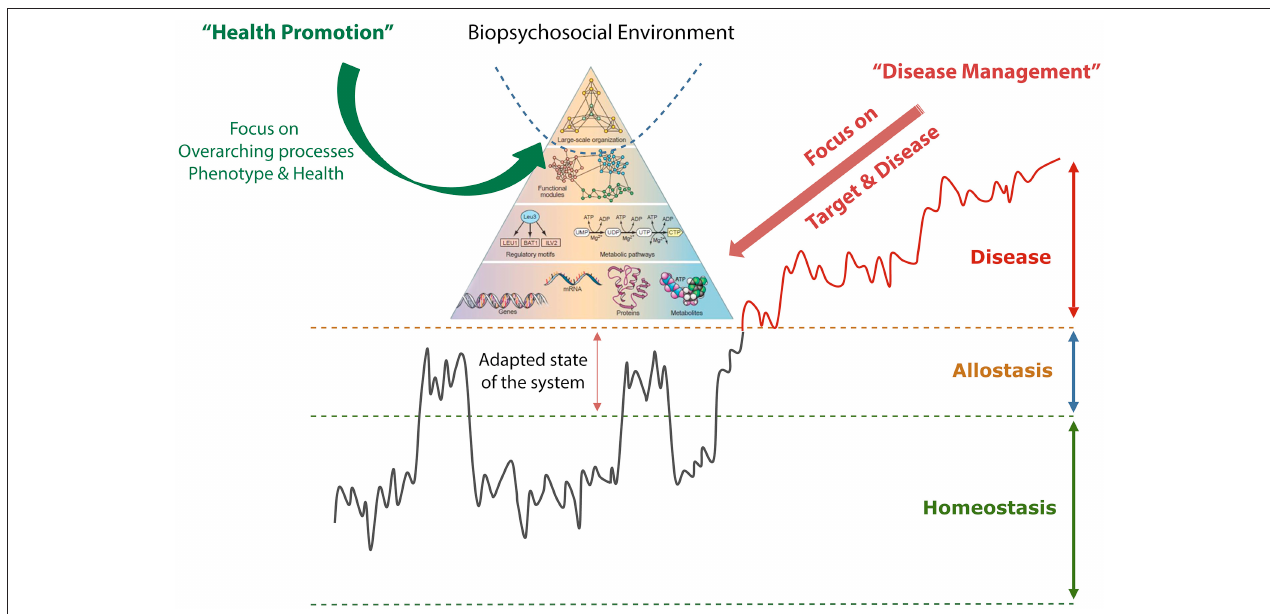
FIGURE 1 | Schematic depiction of the development from health into a disease state. It shows how challenges to homeostasis can be regulated by allostasis by adapting the set points of the regulatory system. If the resilience is lost over time, the system can develop into a disease state. The last part is often handled by disease management focusing on single symptoms. The “life pyramid” view represents the notion of how biological systems are interconnected at different organizational levels and how the biopsychosocial environment acts dynamically within the system and therefore reflects the information at the lower levels. This integrated picture is more applicable to the pre-disease and healthy state and represents the newly emerging picture of how the future healthcare system should focus on promoting health rather than treating disease. Adapted from Oltvai and Barabási (2002), Ramautar et al. (2013), and van der Greef et al.